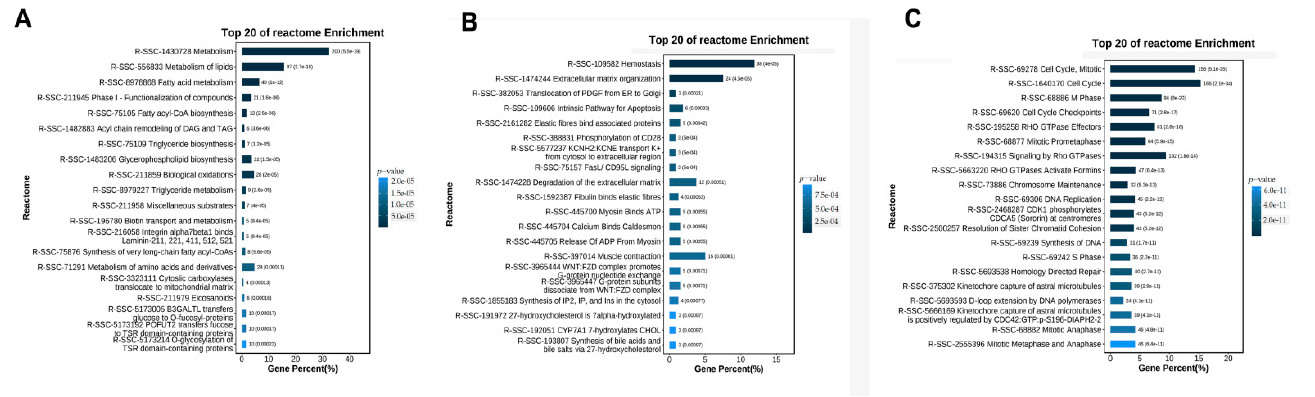
Figure 6. REACTOME pathway enrichment analysis of temporal expressed DE mRNAs. ( A ) Top 20 enriched REACTOME pathways for the up-regulated genes during trans-differentiation. ( B ) Top 20 enriched REACTOME pathways for the genes showed changes in the differentiated midsection. ( C ) Top 20 enriched REACTOME pathways for the down-regulated genes during